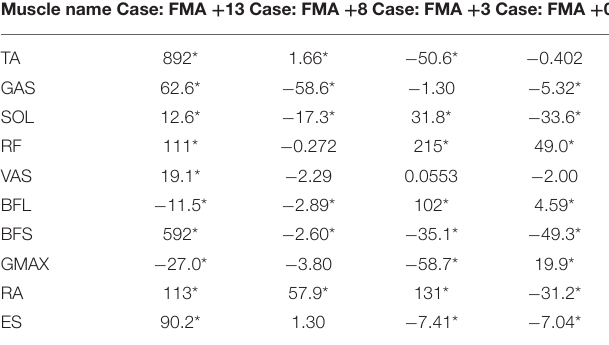
TABLE 2 | Compare muscle tension results from post-stroke cases: changes in maximum muscle tension over the subacute rehabilitation period of four patients with + 13, + 8, + 3, and + 0 points in the Fugl-Meyer Assessment (FMA) of motor